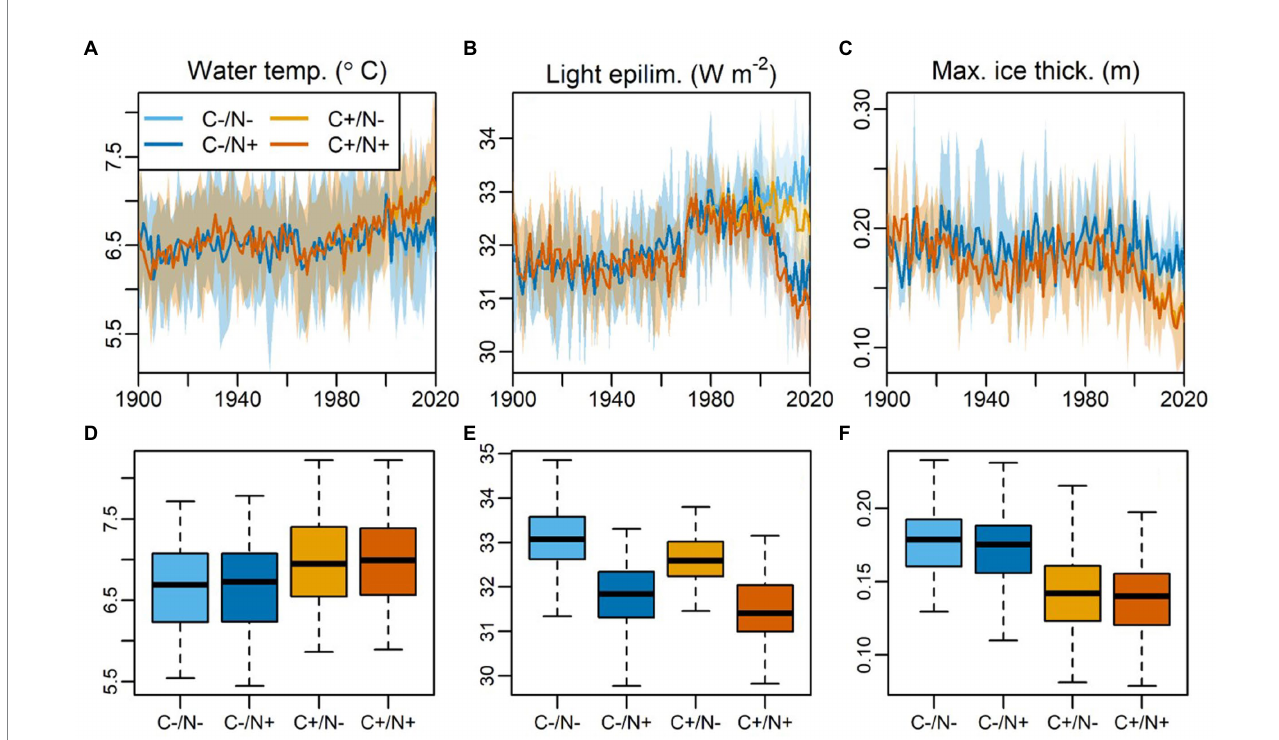
FIGURE 5 Model simulated annual averaged data for (A) epilimnetic water temperature volume-weighted across the epilimnion, (B) light intensity in the lake epilimnion weighted by the area of the water–sediment interface in each modeled layer, (C) maximum ice thickness from 1900 to 2020 under different scenarios. The scenarios are composed for a two-factorial approach. ‘C’ denotes the climate factor (‘C-’ is the ‘piControl’ climate scenario without anthropogenic change, and ‘C+’ is the ‘historical’ with climate change). ‘N’ denotes the nutrient loading factor (‘N-/N+’ represents the scenarios without and with the rapid increase of atmospheric N deposition after ca. 2000s). The shade area represents the modeling range derived from the four Global Climate Models (GCMs) from the ISIMIP project. (D-F) The corresponding boxplots of the variable above during 2000 to 2020 under various modeling